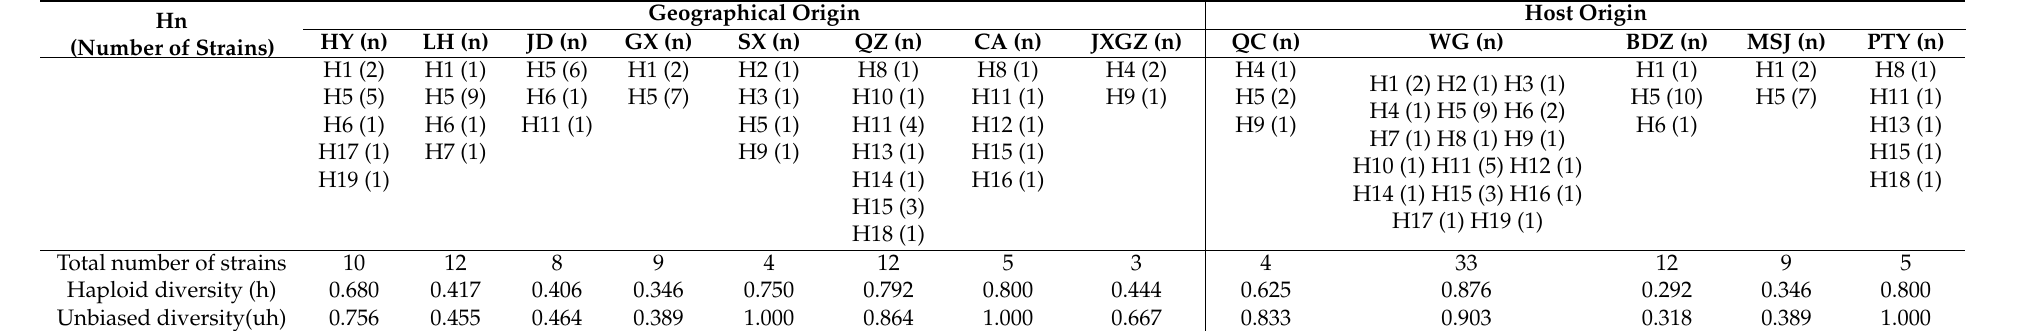
Table 4. Genetic diversity of the Colletotrichum gloeosporioides population from Citrus in